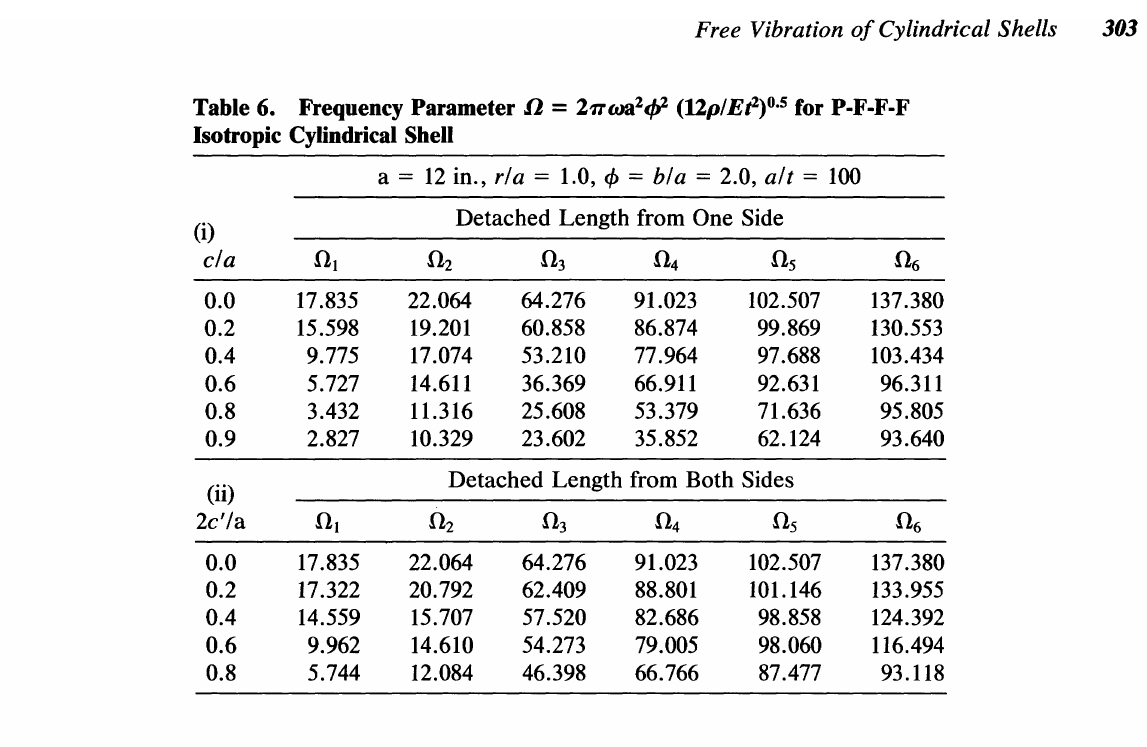
Table 6. Frequency Parameter n Isotropic Cylindrical SheD